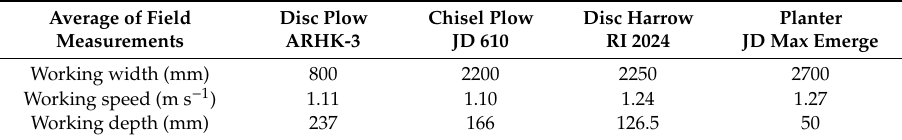
Table 3. Average of the data measured for working speed, width, and depth.